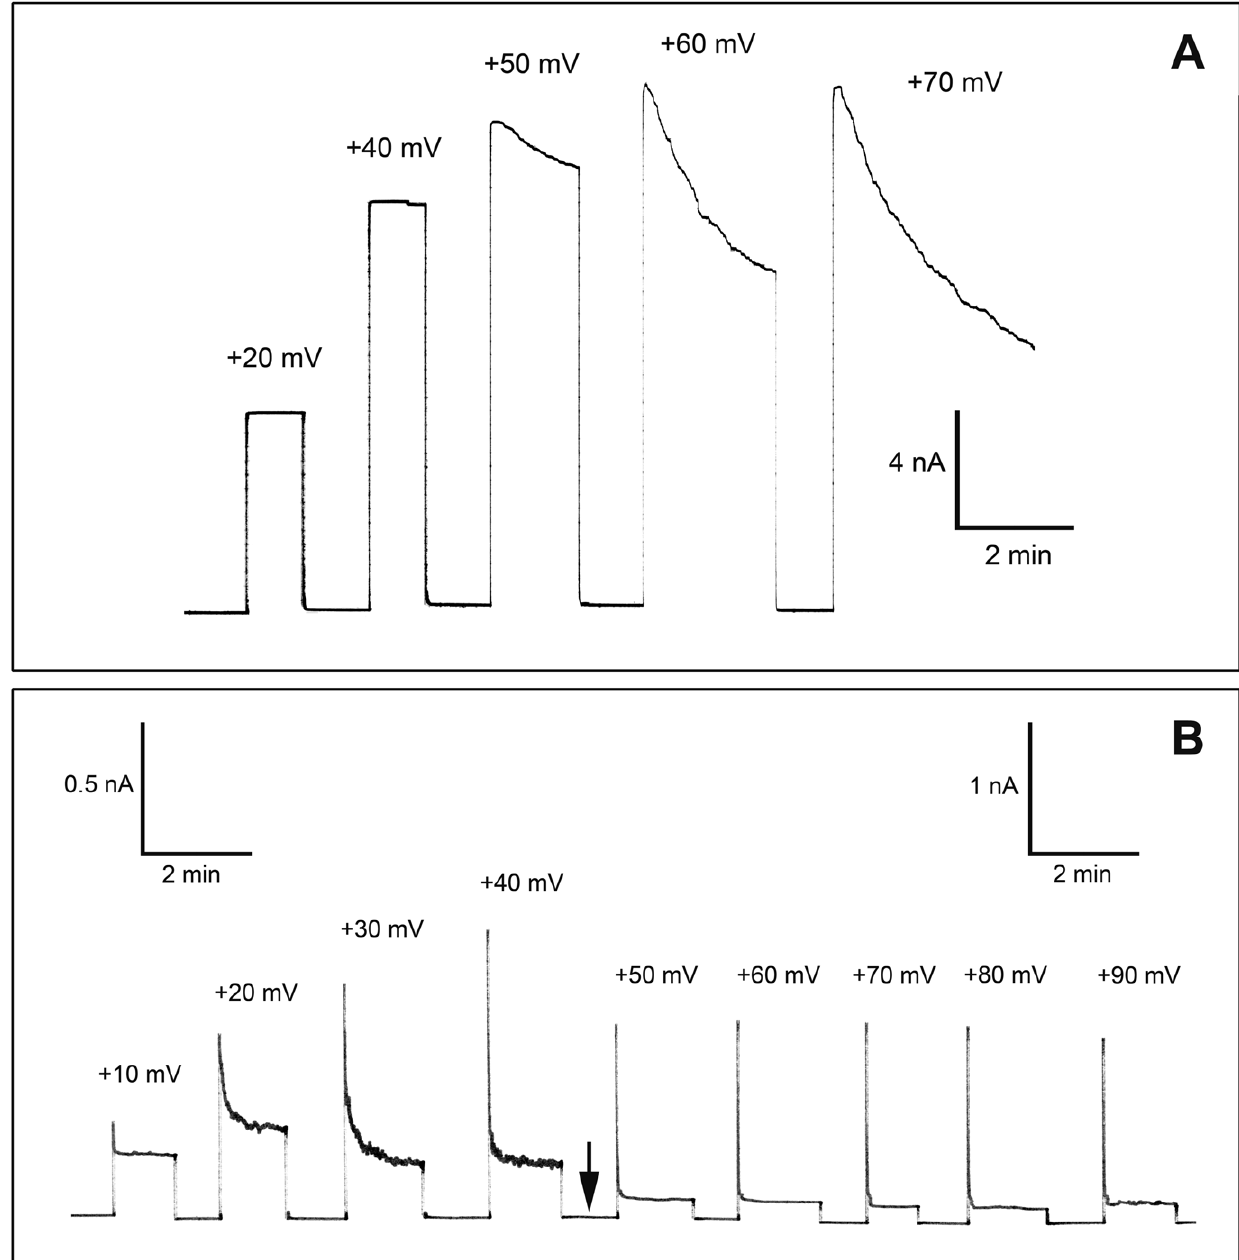
Figure 5. Voltage dependency of PA 63 -channels in the presence of EDIN and His 6 -EDIN. A: Current response of PA 63 -channels in presence of EDIN. Voltage pulses between + 20 and + 70 mV were applied to a diphytanoyl phosphatidylcholine/n-decane membrane in the presence of PA 63 - pores and EDIN (both added only to the cis side of the membrane). The aqueous phase contained 150 mM KCl, 10 mM MES-KOH, pH 6. The temperature was 20 u C. B: Current response of PA 63 channels in the presence of His 6 -EDIN. Voltage pulses between + 10 and + 90 mV were applied to a diphytanoyl phosphatidylcholine/n-decane membrane in the presence of PA 63 -pores and His 6 -EDIN (both added only to the cis side of the membrane). The aqueous phase contained 150 mM KCl, 10 mM MES-KOH, pH 6. The temperature was 20 u C. Note the change of the scale (Arrow).